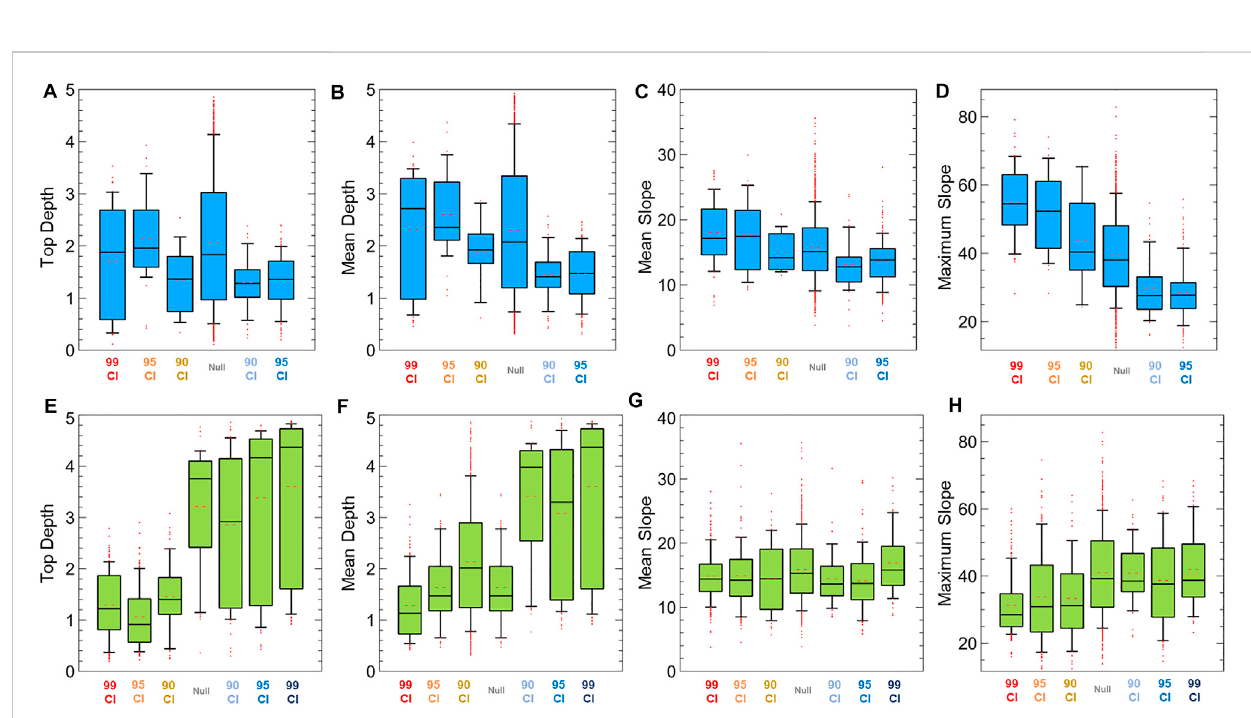
FIGURE 13 Boxplots showing the depth and slope of submarine landslides that are grouped based on the Gi* statistic (blue boxplots, based on volume; yellow green,basedonL/W)inFigure13(redhue,hotspots;bluehue,coldspots).Reddotsindicatetheoutliers, whilebrokenlinesinsidetheinterquartilerange (IQR) show the mean value. (A – D) Box plots based on the volume show that signi fi cant clusters of large submarine landslides have depths with wide IQR (0.1 – 4 km), while small ones are in a narrow IQR of about 0.1 – 2 km. Mean slope (C) tends to concentrate between 10 ° and 30 ° with slightly lower values for signi fi cantly small-volume submarine landslides. (D) Maximum slope showed a positive association with clusters of signi fi cantly large-volume submarine landslides, whereas small-volume landslides have a lower maximum slope. (E – H) Clusters of signi fi cantly high L/W occur in shallower depths and slightly lower slopes than those of signi fi cantly low